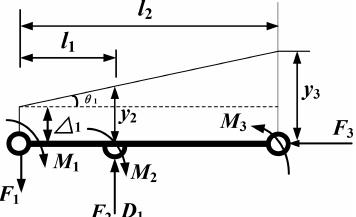
Figure 8. Analysis diagram of the horizontal lever mechanism.